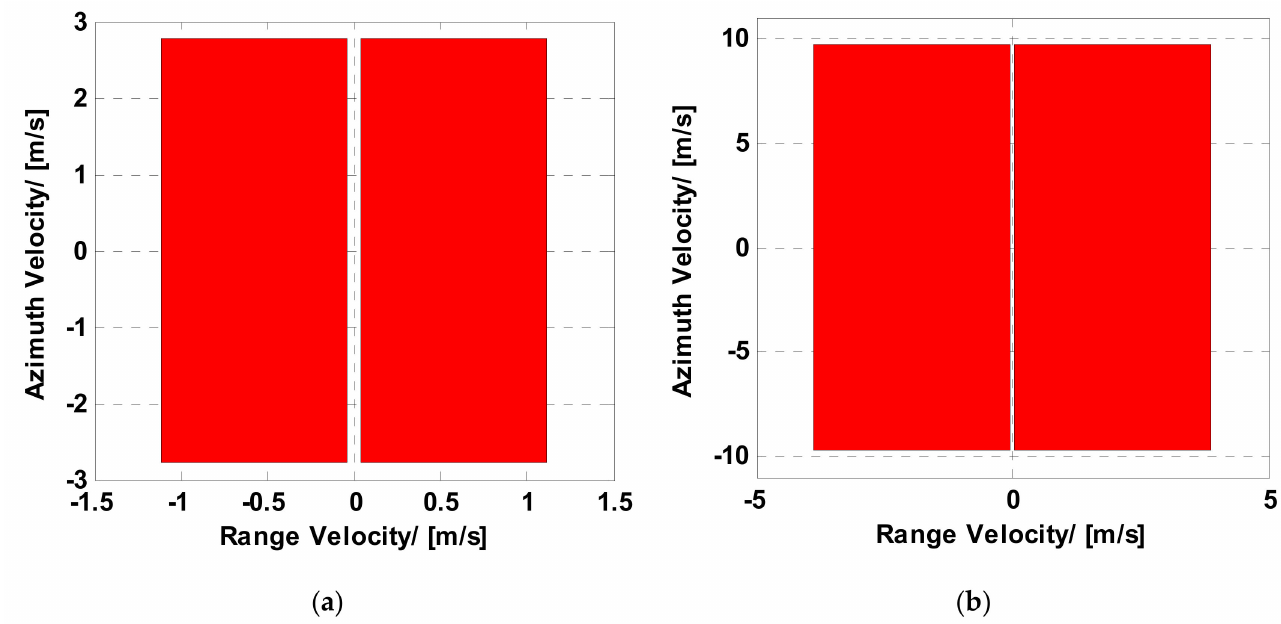
Figure 18. Moving target velocity and detection limitation with ( a ) X-band and ( b ) Ka-band.